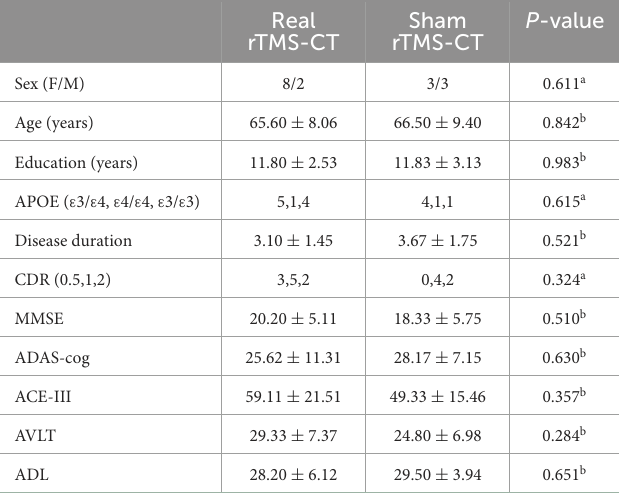
TABLE 1 Demographic data of the participants at